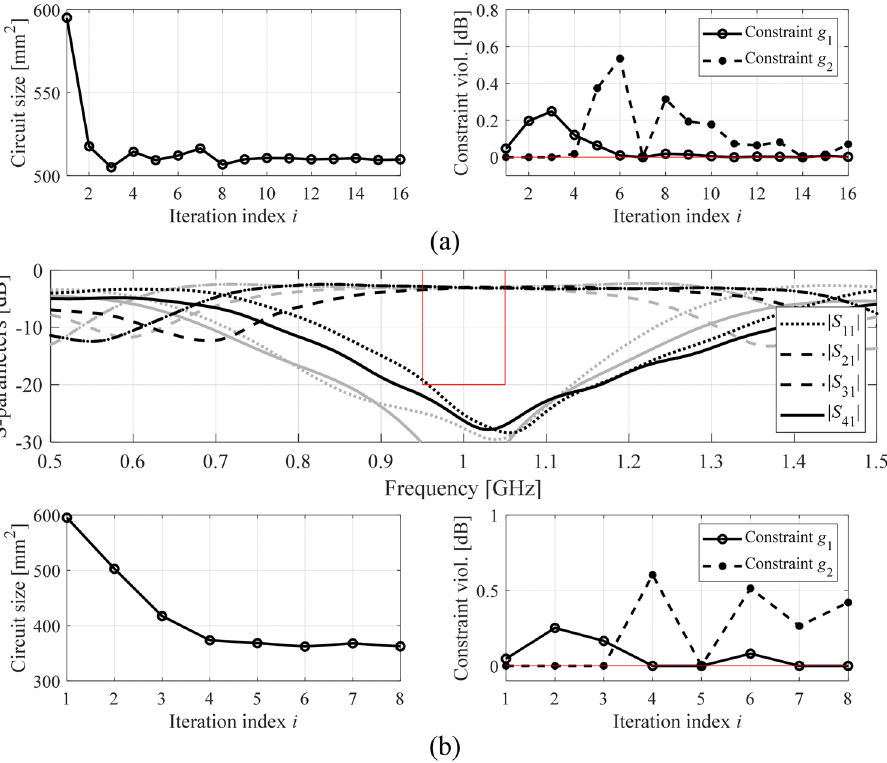
Figure 5. Initial (gray) and optimized (black) S -parameters of Circuit II. The vertical and horizontal lines mark the target operating bandwidth and the acceptance level for the matching | S 11 | and isolation | S 41 | responses. Also shown is the evolution of the circuit size and constraint violations (in case of feasibility, violations shown as zero): ( a ) design scenario I (bandwidth 0.9–1.1 GHz), ( b ) design scenario II (bandwidth 0.95–1.05